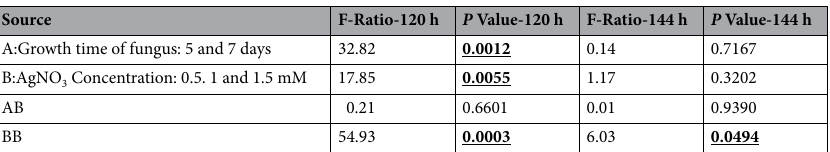
Table 3. Variance analysis for the variable area under the curve. Growth time of fungus 120 and 144 h-anamorphous Bjerkandera sp. R1.